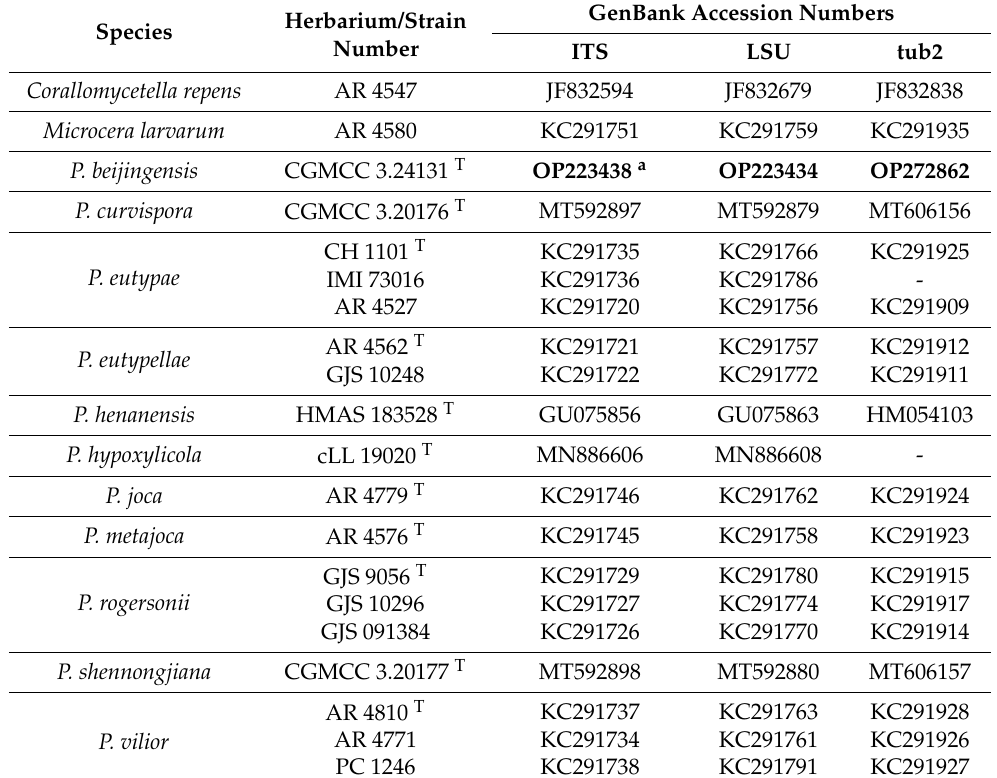
Table 2. List of Pseudocosmospora species, herbarium/strain numbers, and GenBank accession num- bers of materials used in this study.